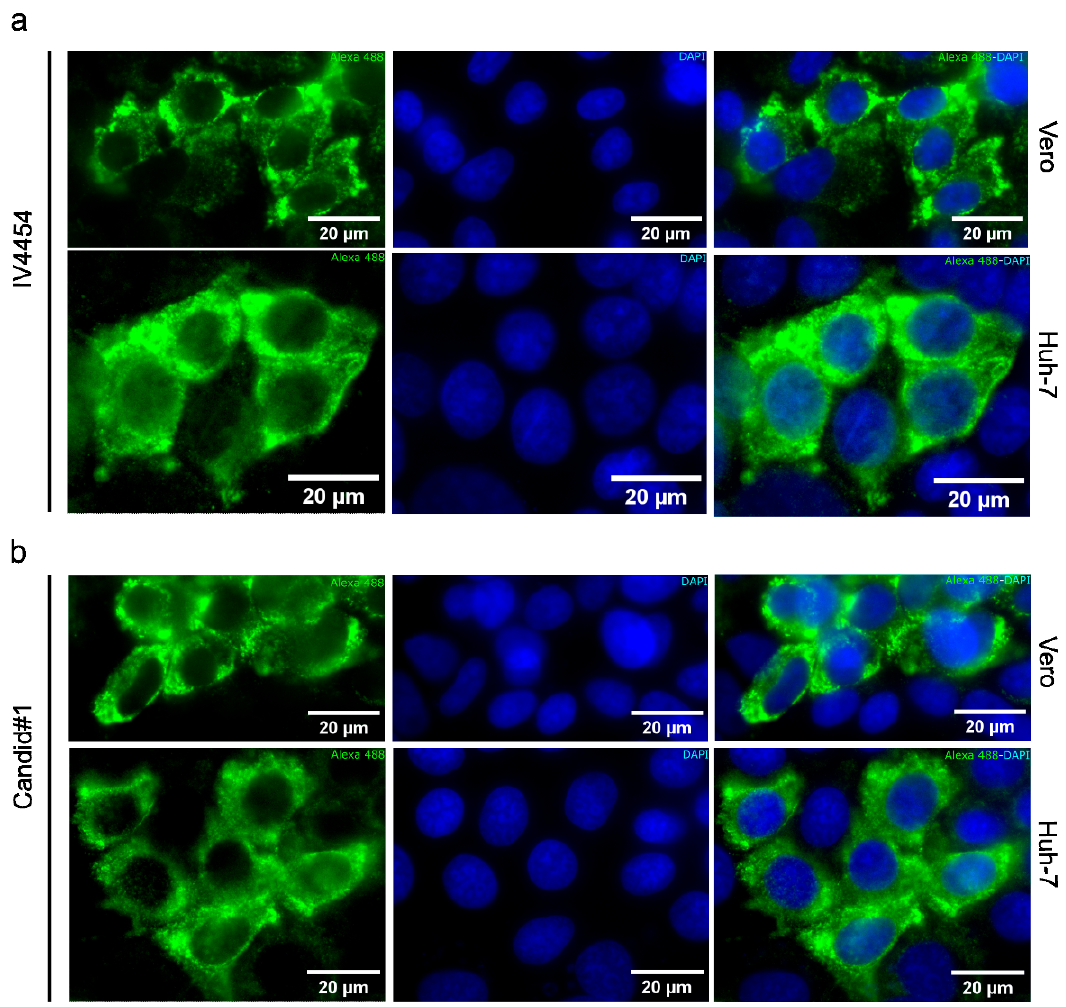
Figure 4. JUNV NP protein distribution on infected cells. Vero and Huh-7 cells were infected with IV4454 ( a ) and Candid#1 ( b ) (MOI = 0.5) for 48 h. Then cells were fixed and processed through immunofluorescence. NP was stained with Alexa 488 (green), and cell nuclei were stained with DAPI (blue). Scale bar: 20 µm. Magnification: 600×.